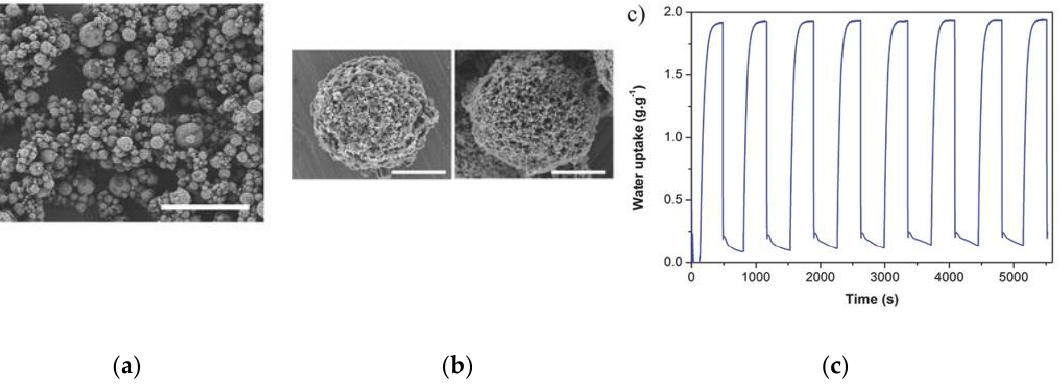
Figure 12. ( a ) Representative FESEM image of microspherical CaCl 2 @UiO-66, ( b ) FESEM images of microspherical CaCl 2 @UiO-66_38 superstructures before (left) and after (right) incubation in ethanol, ( c ) adsorption and desorption cycles for CaCl 2 @UiO-66_38. Scale bars: ( a ) 20 μm, ( b ) 3 μm. Reproduced with permission from [89]. Wiley, 2016.